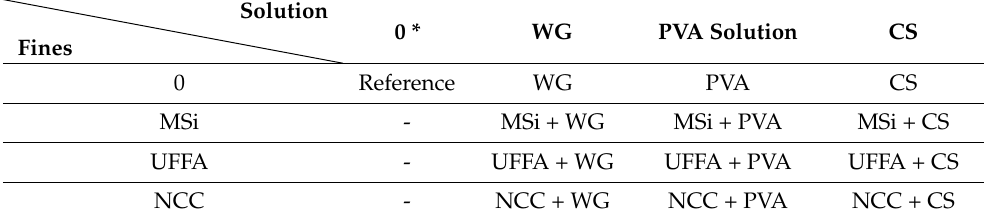
Table 2. Cases for the strengthening of recycled aggregates.